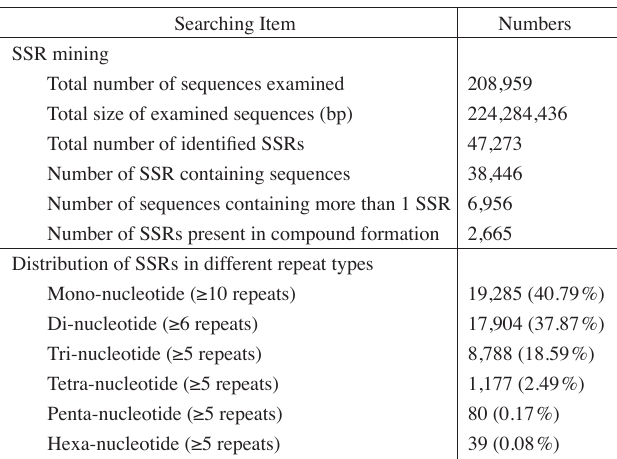
Tab. 2: Statistics of SSRs identified in Oplopanax elatus transcriptome assembly.